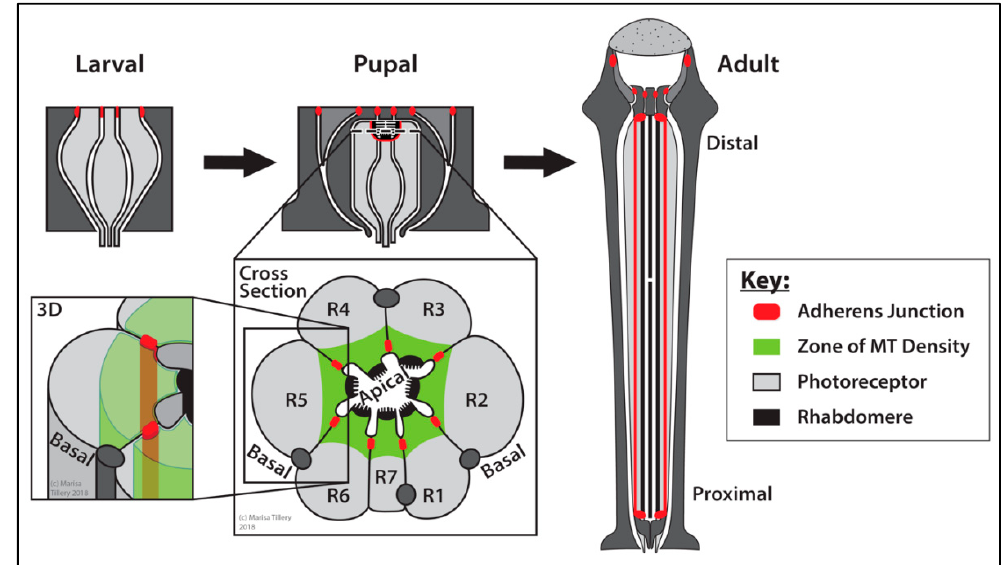
Figure 11. MTs are organized in photoreceptor cells near the apical membrane where the rhabdomere forms. This set of MTs appear to be organized from an undefined ncMTOC.